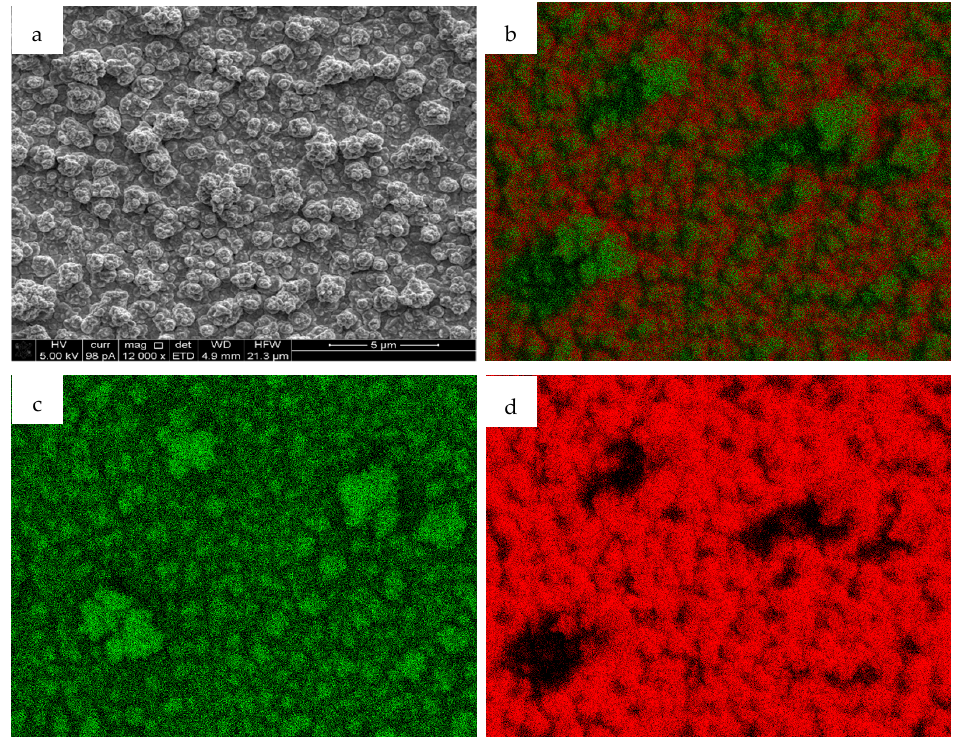
Figure 1. SEM image ( a ) and Auger mappings ( b ) of Ni-Cu deposit onto niobium substrates: Cu in green and Ni in red. The separated Auger mappings of Cu and Ni are reported in ( c ) and ( d ), respectively.